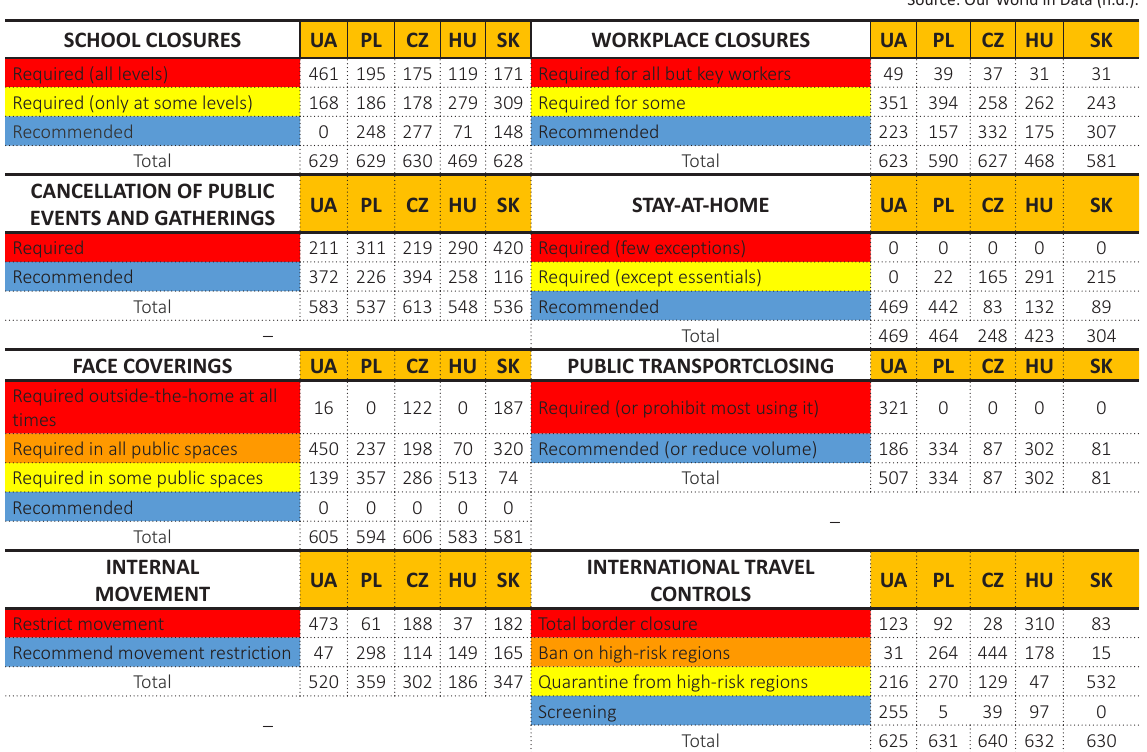
Table 2. Quarantine measures duration in Ukraine and Visegrad Group